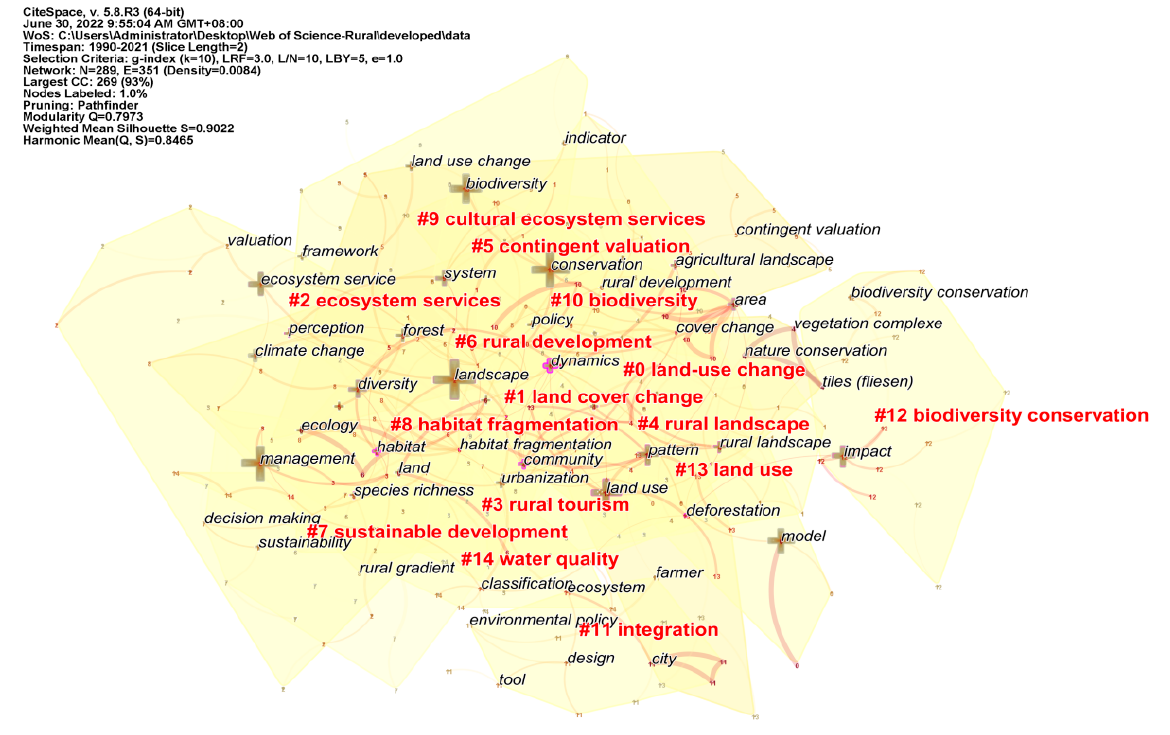
Figure 9. Keyword co-occurrence clustering map in developed